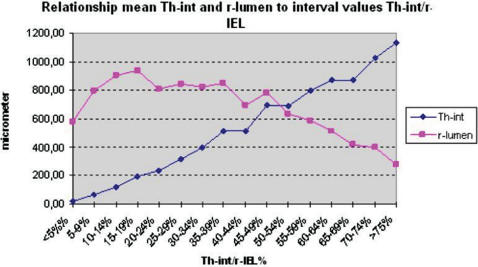
Line diagram relation mean radius lumen (r-lu) and thickness intima (Th-int) for 5% Th-int/r-IEL (thickness intima/radius Internal Elastic Lamina) intervals.